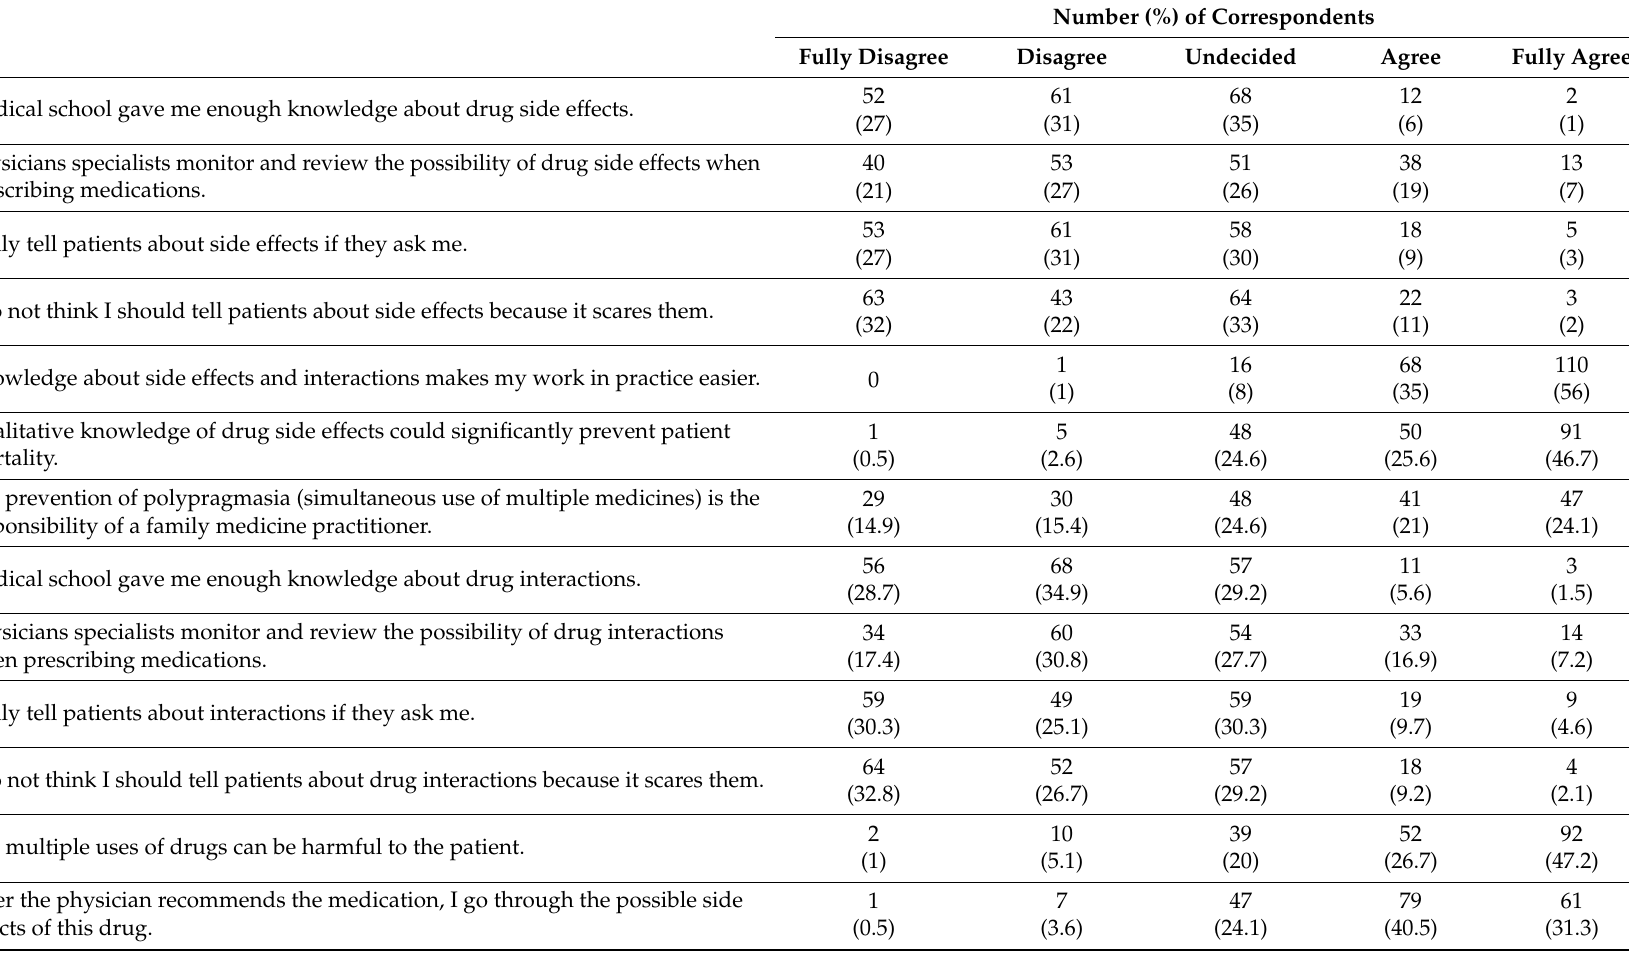
Table 5. Attitudes towards counseling about drug interactions and side